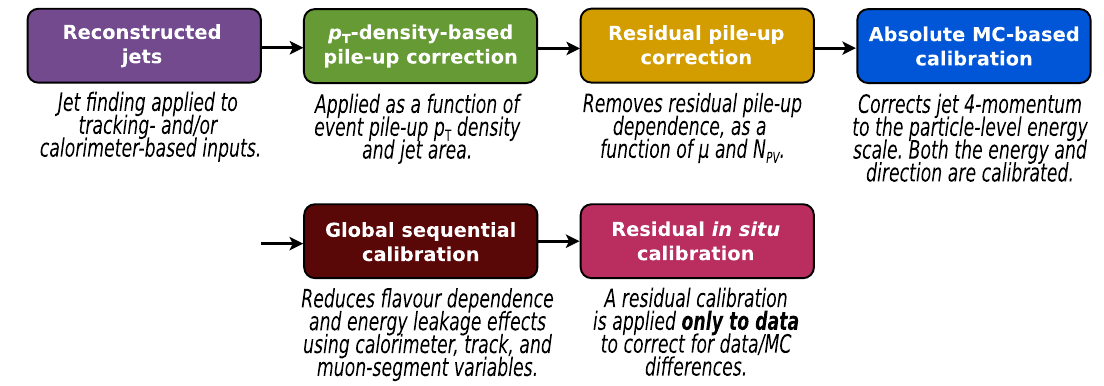
Fig. 2 Stages of jet energy scale calibrations. Each one is applied to the four-momentum of the jet